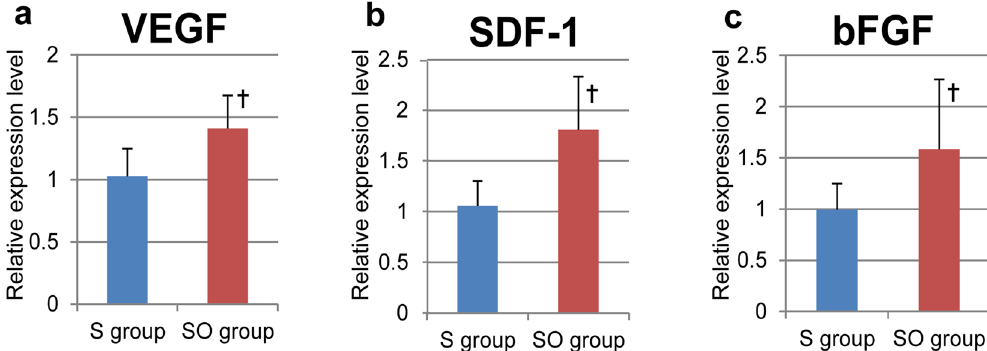
Figure 7. Angiogenesis-related mRNA expression in the transplanted area, as measured by RT-PCR. ( a – c ) Relative expression of angiogenesis-related factors at the transplanted area was significantly greater in the SO group than in the S group ( a ). VEGF, † P < 0.05; ( b ) SDF-1, † P < 0.05; ( c ) bFGF, † p < 0.05 vs. the S